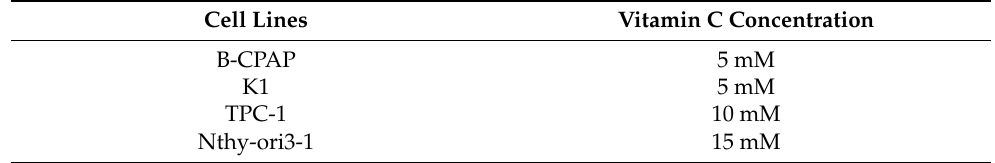
Table 1. Concentration of vitamin C able to induce 50% of cell death in PTC-derived and control cells.